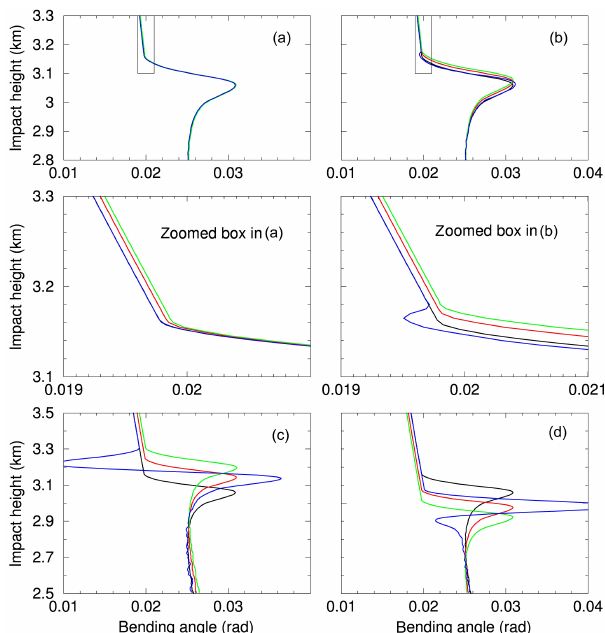
Figure A3. Bending angle profiles obtained from modeling by ray tracing. Black: bending angle obtained with the atmosphere only. Red and green: L1 and L2 bending angles obtained with the atmo- sphere and ionosphere. Blue: ionospheric-free bending angles.